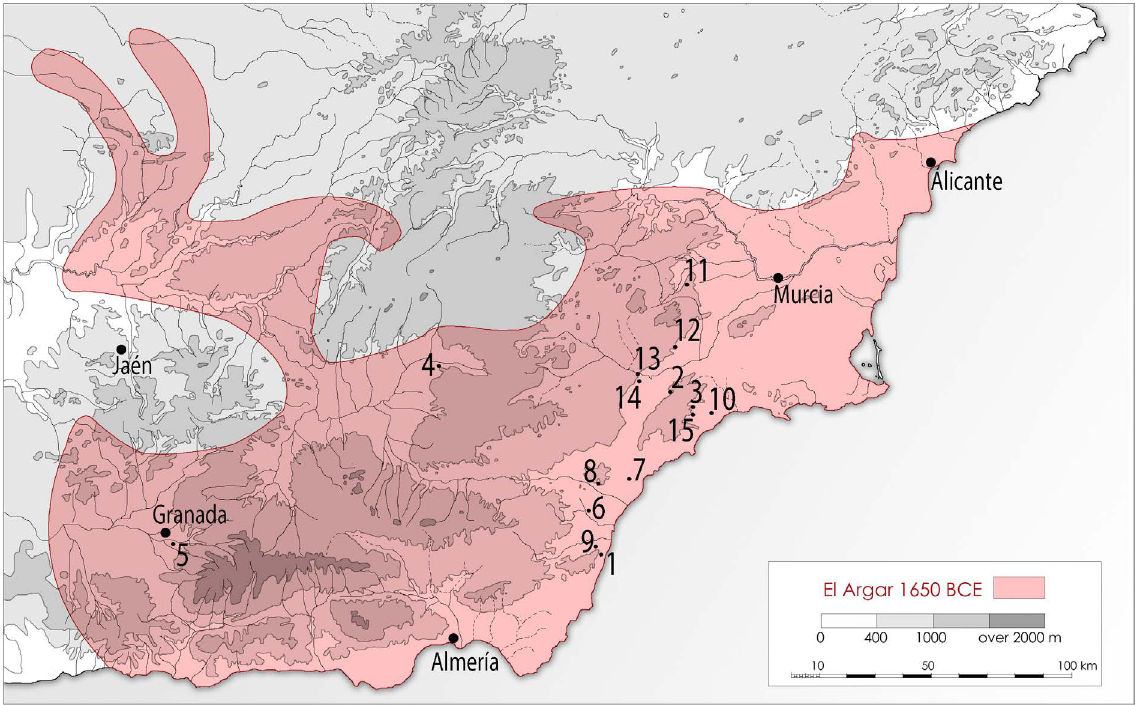
Figure 1. Maximal extension of El Argar around 1650 BCE and other sites mentioned in the text. 1. Barranco Ciudad; 2. Barranco de la Viuda; 3. Cabezo Negro; 4. Cerro de la Virgen; 5. Cerro de la Encina; 6. El Argar; 7. El Oficio; 8. Fuente Álamo; 9. Gatas; 10. Ifre; 11. La Almoloya; 12. La Bastida; 13. Lorca; 14. Los Cipreses; 15. Zapata. The lower scale bar is 100 km